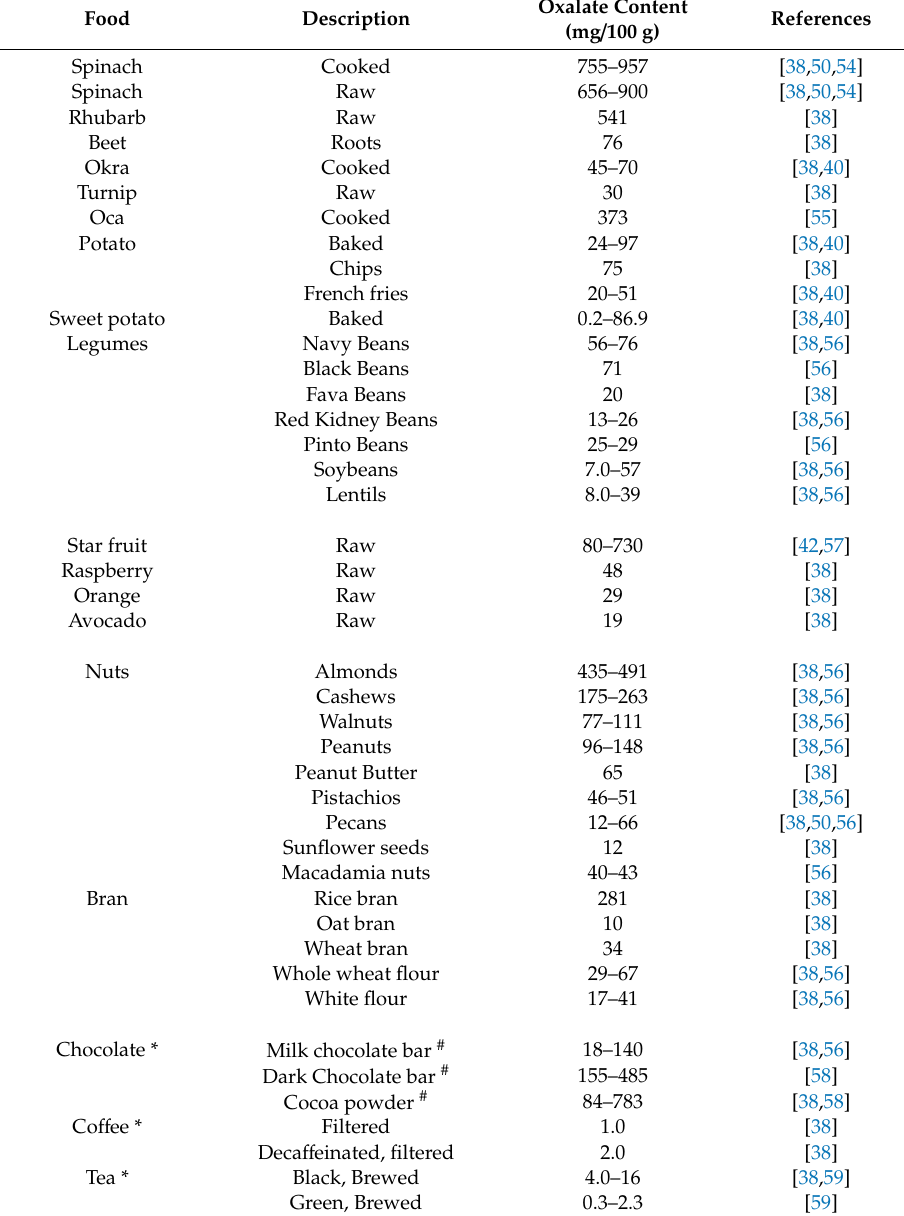
Table 1. Oxalate content in foods (mg /